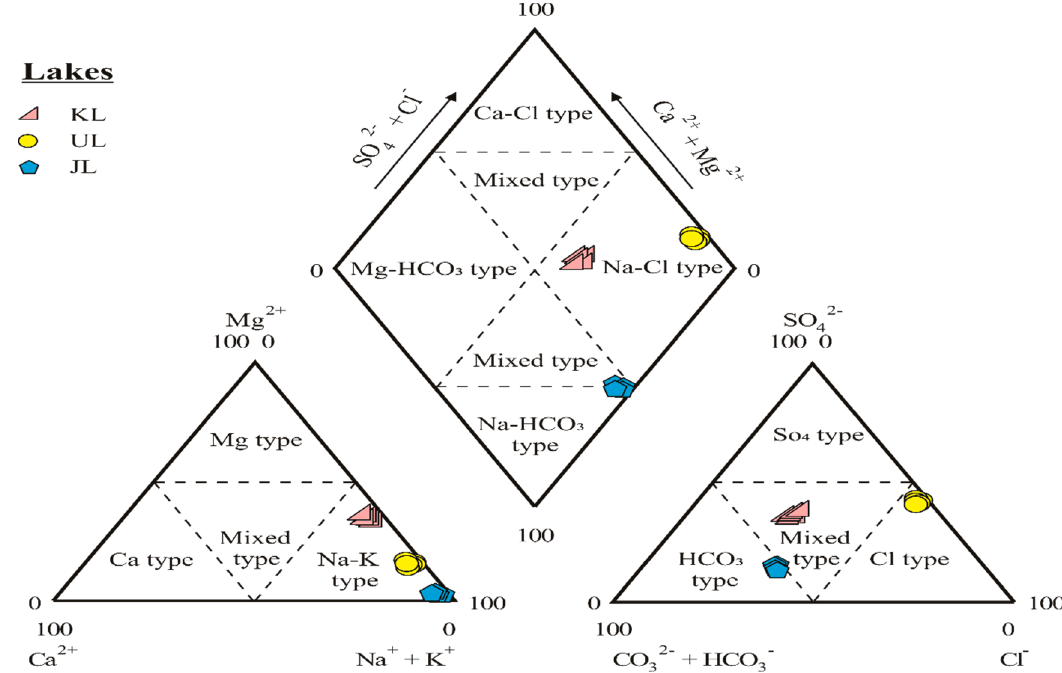
Figure 3 . Piper diagram showing the different hydrofacies of the three saline lakes. Figure 3. Piper diagram showing the di ff erent hydrofacies of the three saline